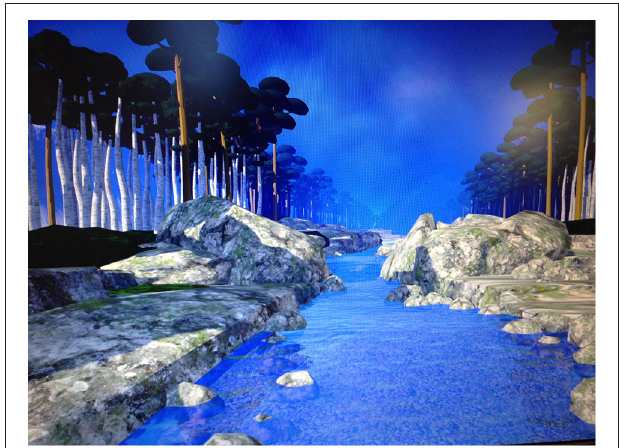
FIGURE 1 | A sample of the virtual reality world the SCI patients experienced in their Oculus Rift DK2 VR goggles while listening to Dr. Linehan’s DBT ® Mindfulness Skills TM audios (http://behavioraltech.org). Image by www. bigenvironments.com, copyright Hunter Hoffman,